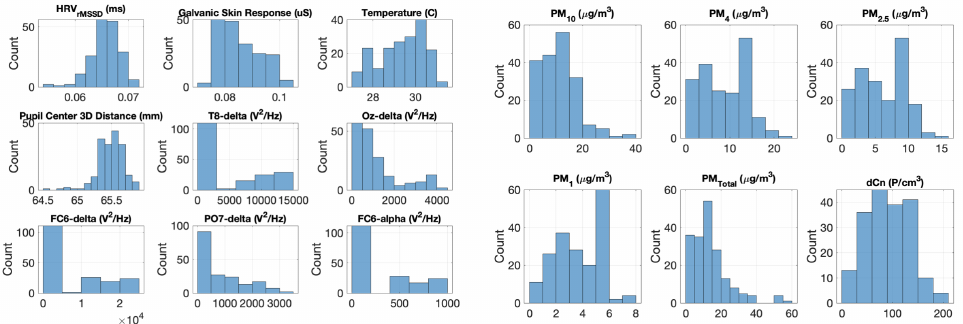
Figure 8. ( Left ) Histograms of 9 EEG and non-EEG predictor variables. Plots are titled by variable name and its physical units. ( Right ) Histograms of 6 different PM target variables variables. Plots are titled by variable name and its physical